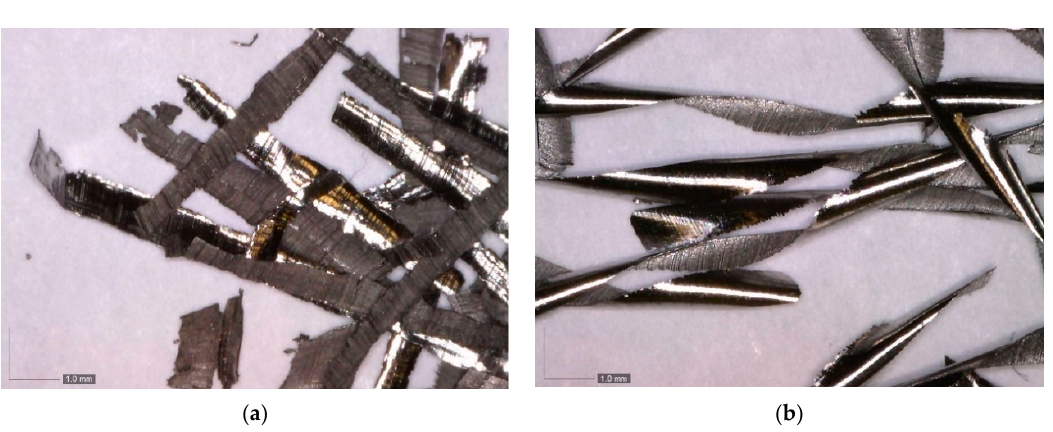
Figure 10. Chips obtained during end milling of walls: ( a ) LMD-AD; ( b ) forged-SA.